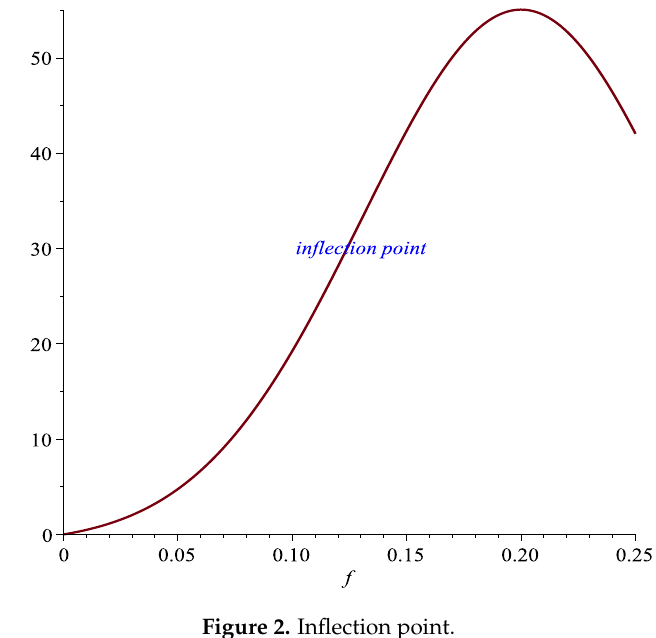
Figure 2. Inflection